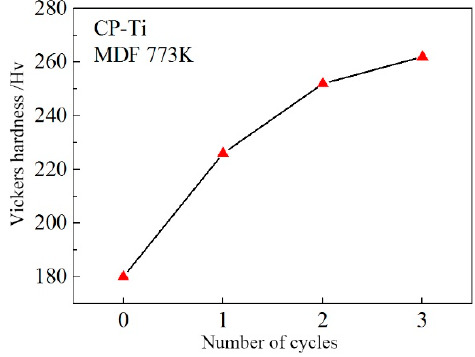
Figure 6. The average Vickers hardness versus the MDF cycles of CP Ti.